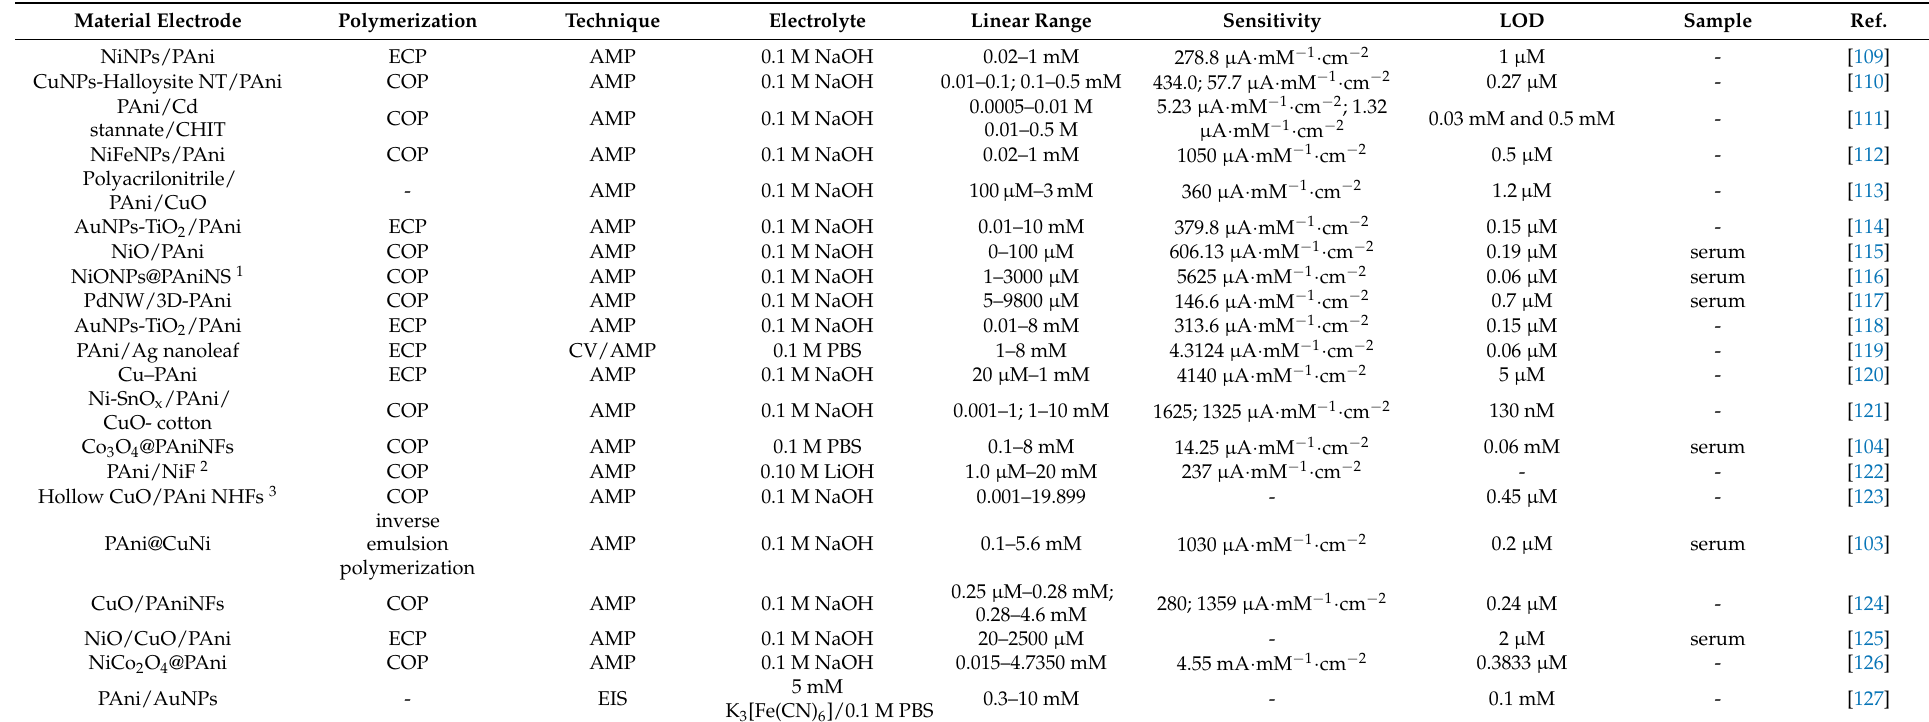
Table 3. Non-enzymatic PAni/nanomaterials based glucose